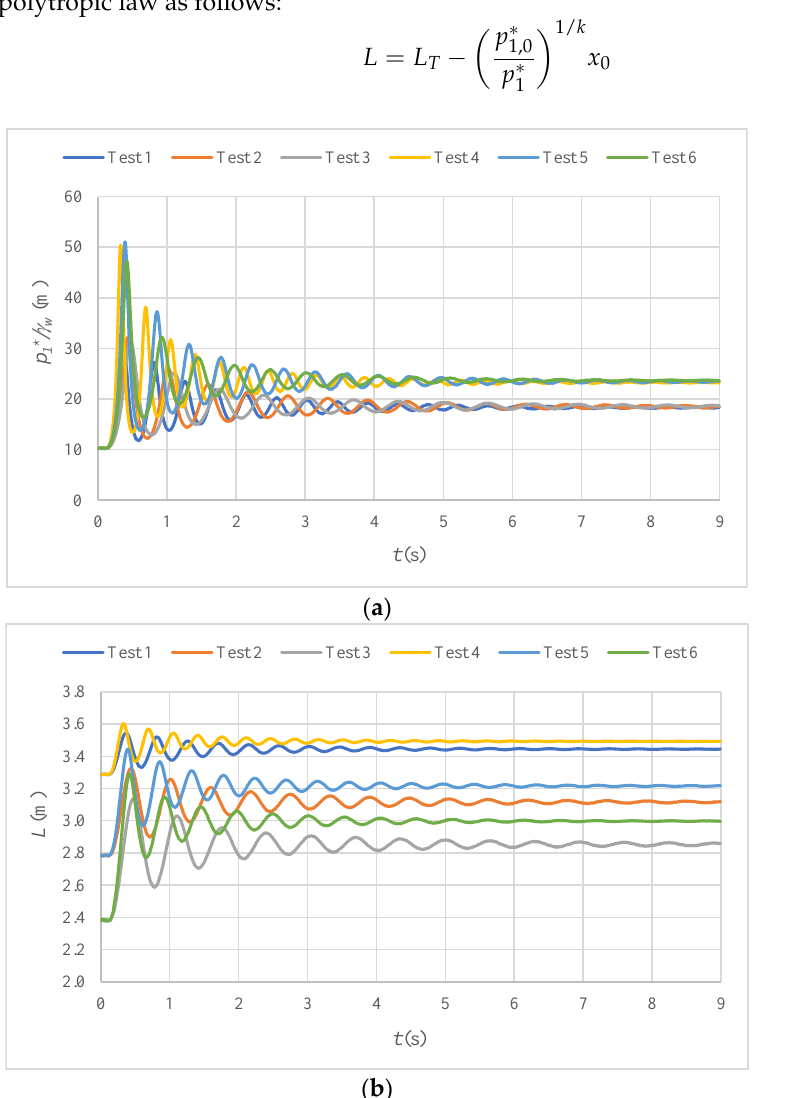
Figure 9. Evolution of the analyzed variables for the experimental facility: ( a ) air pocket pressure; and ( b ) water column lengths.